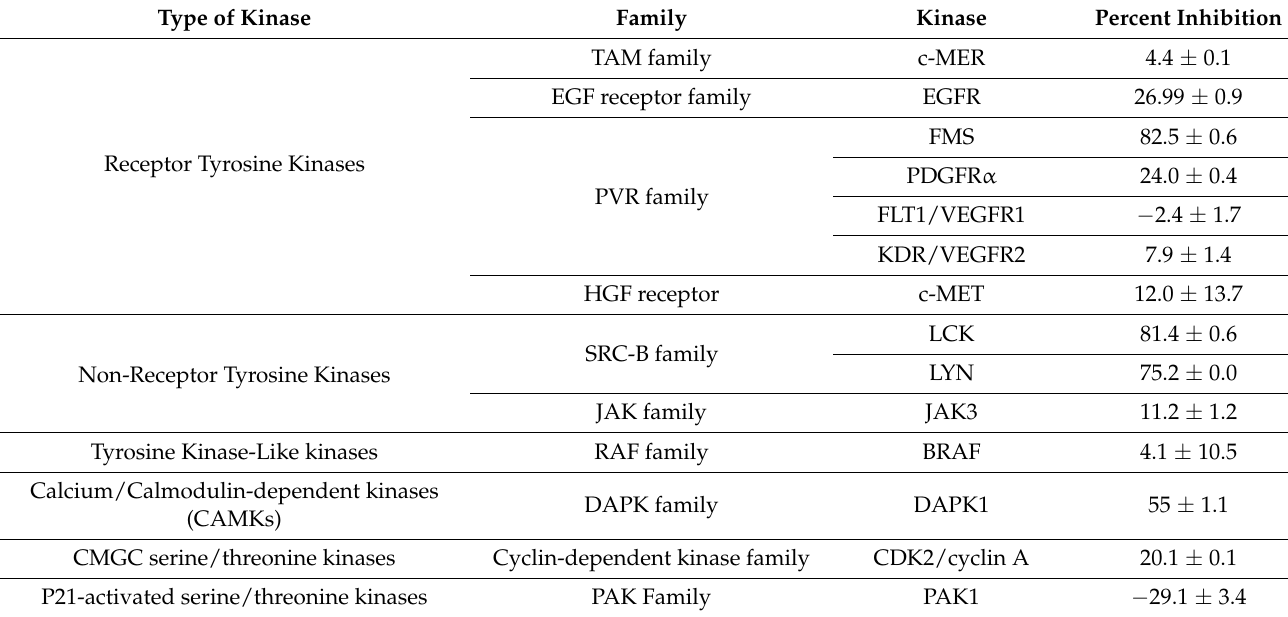
Table 1. In vitro inhibition screening results of compound 5a against a panel of 17 kinases at a single dose of 10 µM.